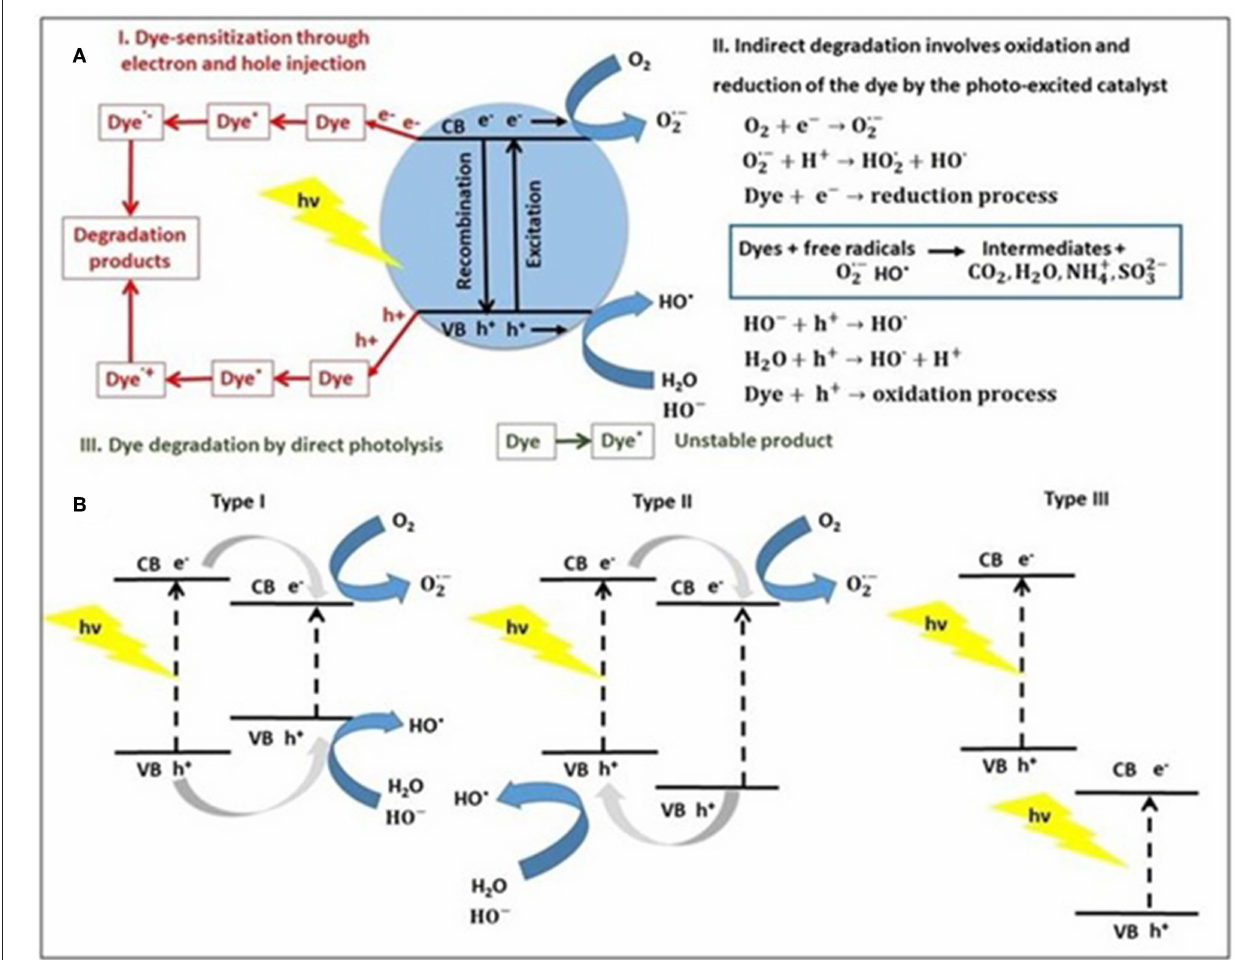
FIGURE 1 | (A) The general photocatalytic degradation mechanisms of dye using a single semiconductor (e.g., metal sulfide) and (B) type of semiconductor heterojunctions based on metal sulfide, under light irradiation.